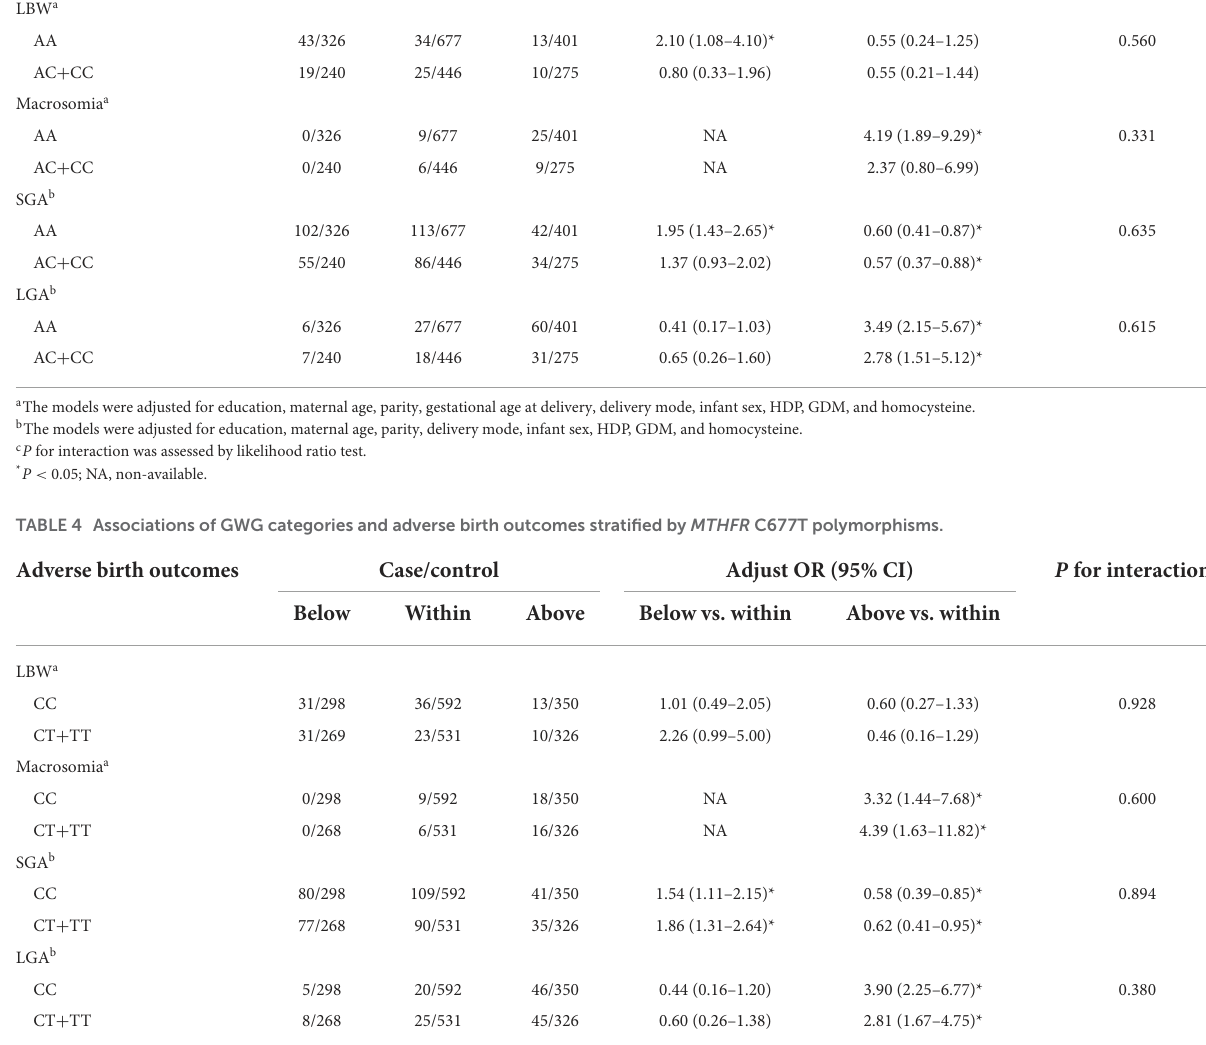
polymorphism was observed (Table 5, Supplementary Table S3). Dose-response relationship between GWG values and 4 adverse birth outcomes with spline smoothing function among pregnant women with MTHFR A1298C AA genotype was shown in Supplementary Figure S2. A negative correlation of GWG was suggested in relation to LBW and SGA, while a positive correlation of GWG was indicated in relation to macrosomia and